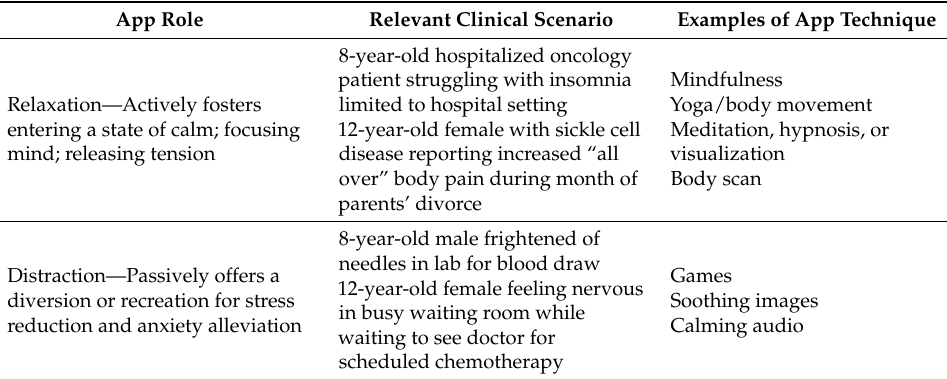
Table 1. Role of technology in a pediatric medical